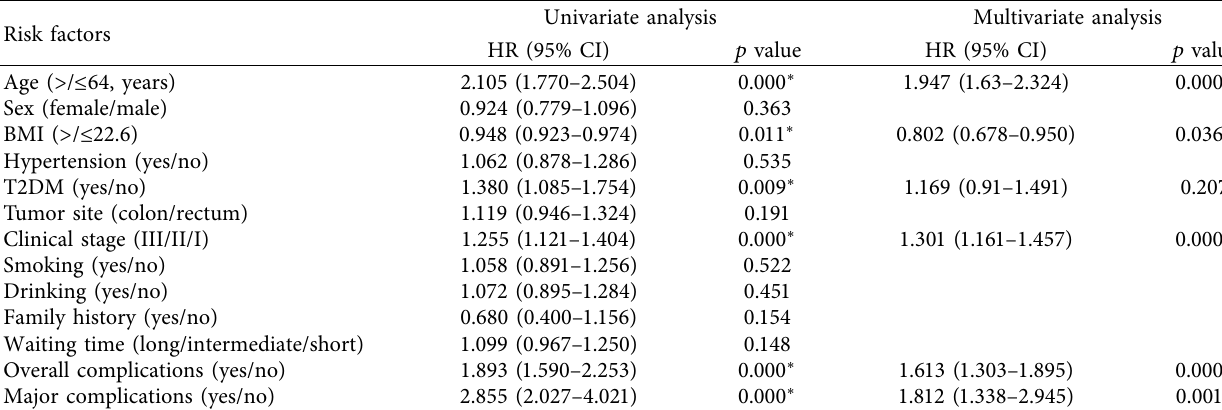
Table 3: Univariate and multivariate analysis of overall survival.